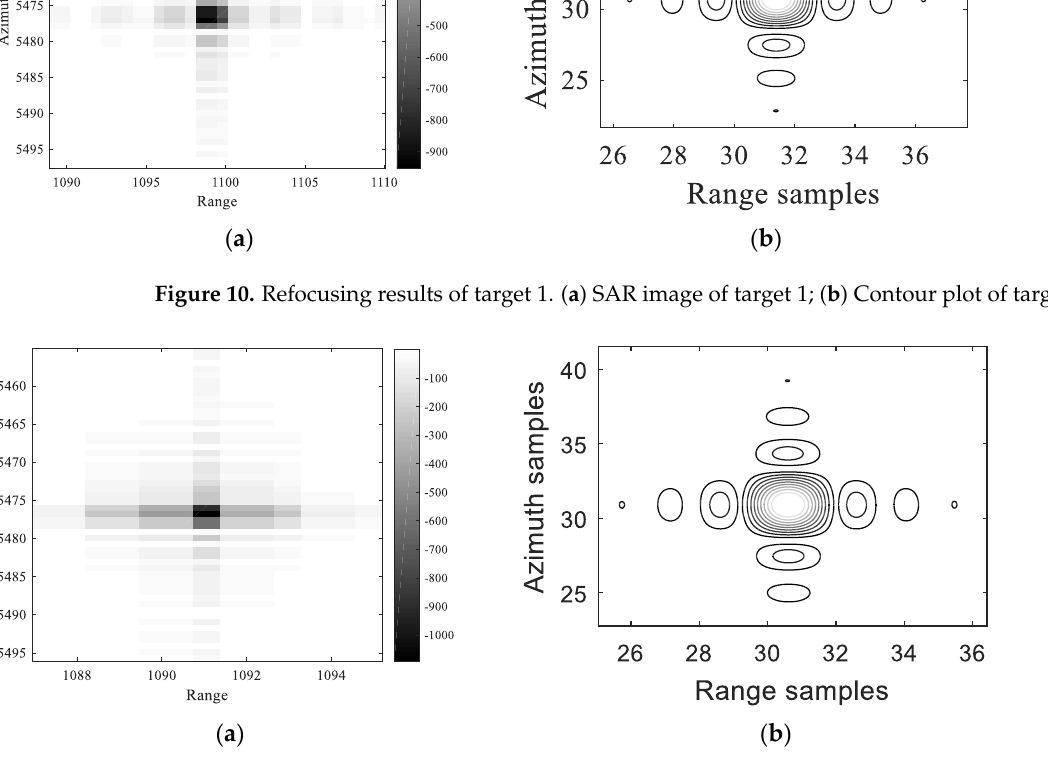
Figure 11. Refocusing results of target 2. ( a ) SAR image of target 2; ( b ) Contour plot of target 2.